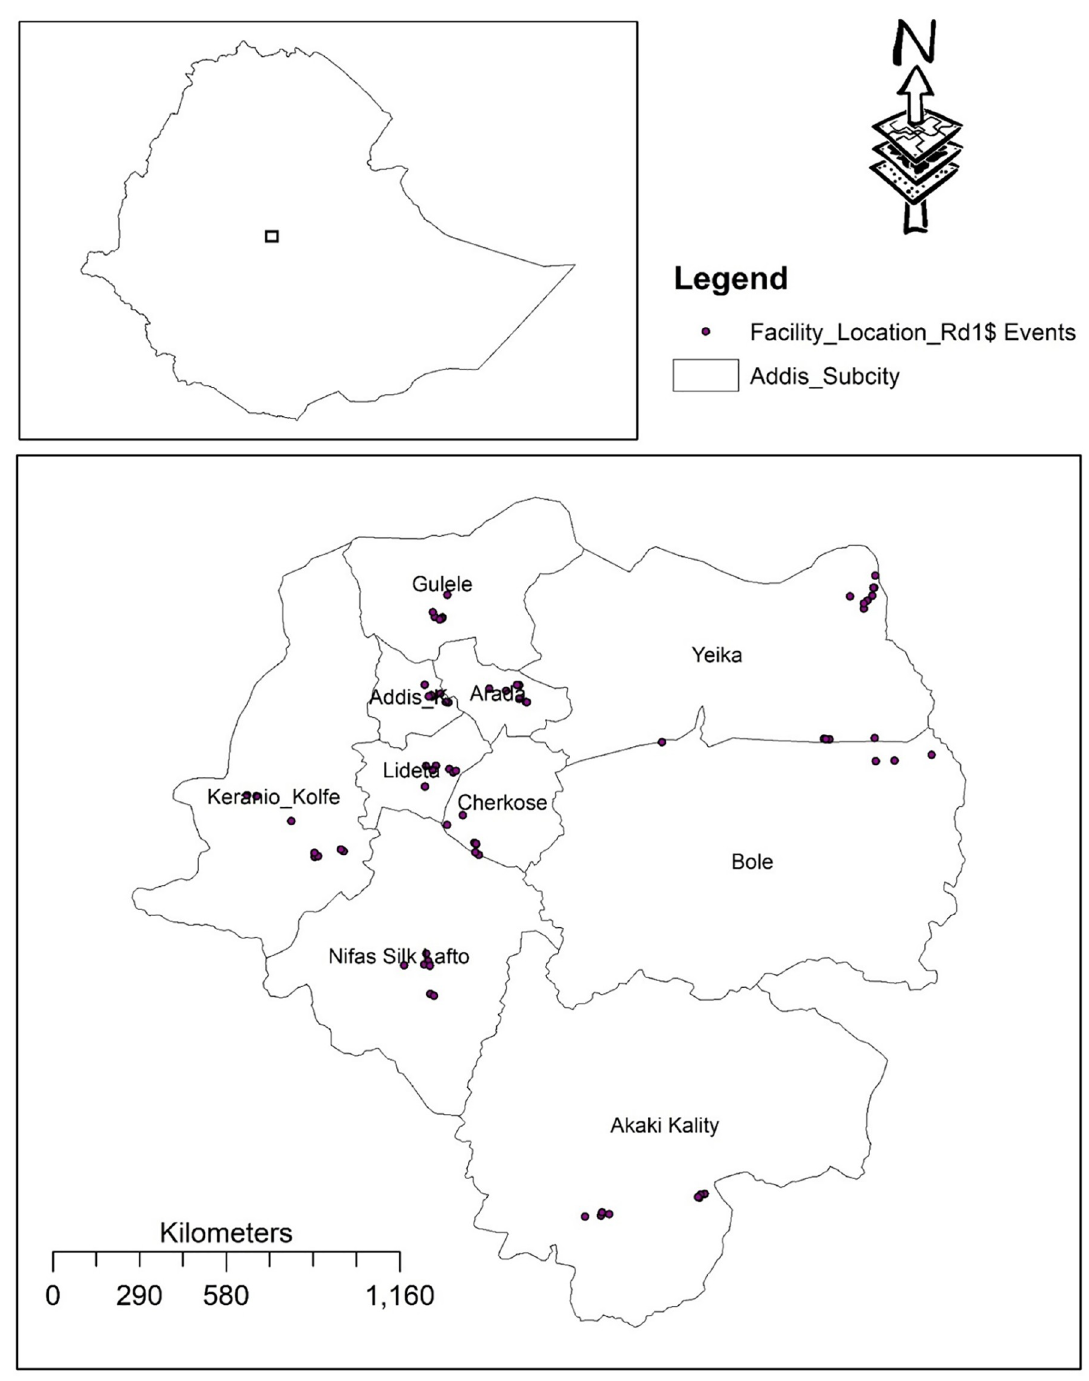
Fig 1. Observational data collection sites in Addis